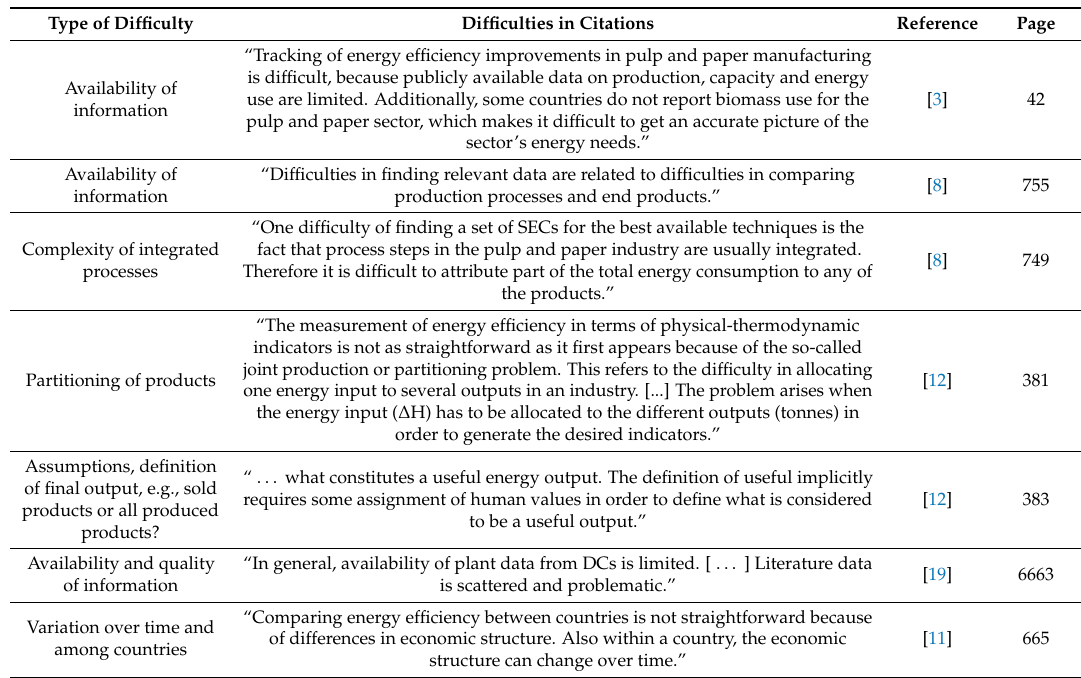
Table 1. Examples of difficulties that have been cited in some of the references using specific energy consumption (SEC). DC—Developing